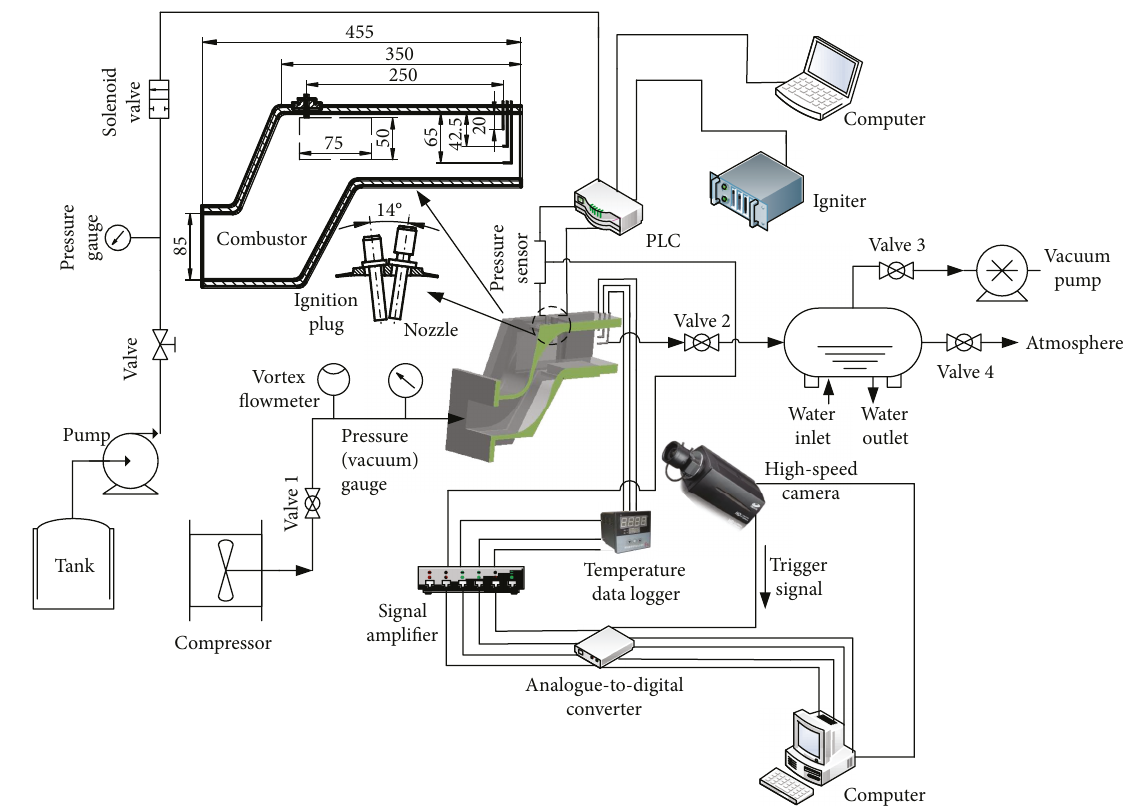
Figure 1: Test system for the ignition of spray